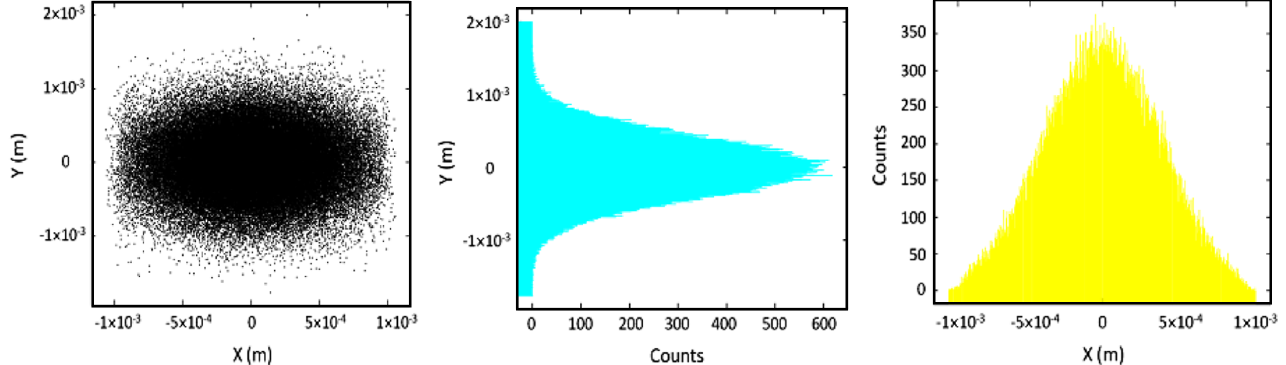
FIG. 5. (Color) Particle distribution after horizontal collimation for the CS parameters listed in Tables I and II, half aperture ¼ 1 : 4 mm . From left to right: physical transverse plane ð x; y Þ observed downstream of the CS, where (cid:2) ¼ (cid:2) ¼ 0 : 415 mm ; horizontal particle distribution with (cid:9) distribution with (cid:9) y code output for 10 5 initial particles.